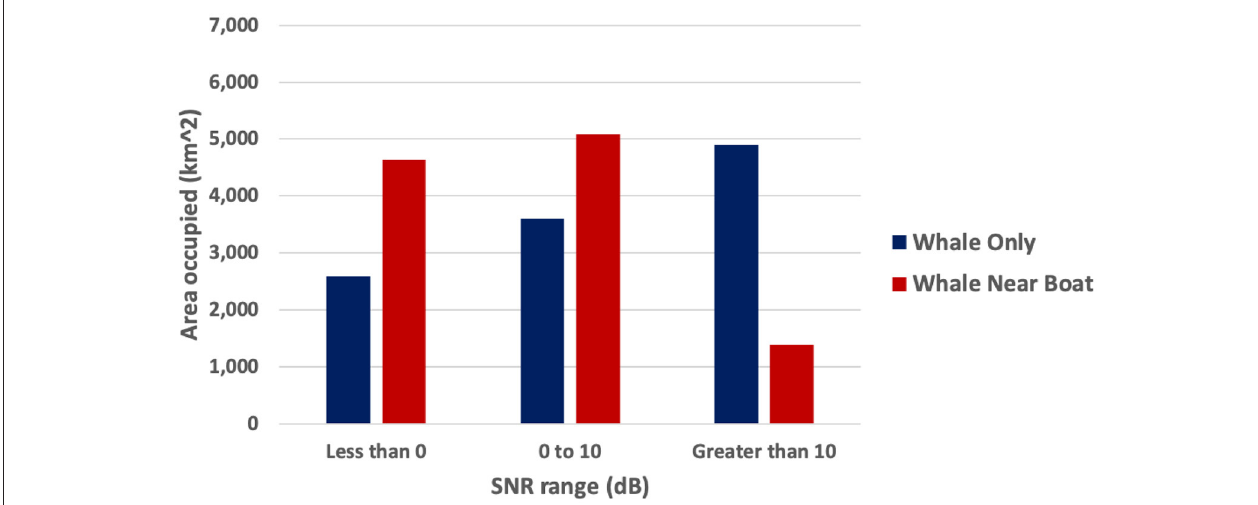
FIGURE 5 | Sept 20, 2019, scenario. #2, side-by-side bar plots of the area covered by each SNR bin of the hypothetical whale song when only ambient noise (blue/left bars) and two boats (red/right bars) were present (color online).